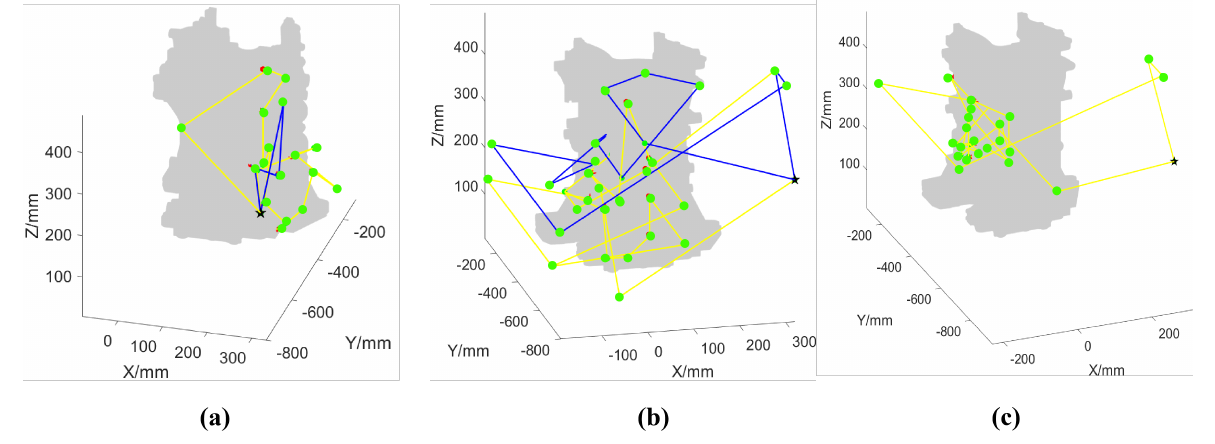
Figure 14. Inspection path diagram based on MSS algorithm. ( a ) Collision-free path for groups 1–2, in which yellow line represents the path of S 1 and blue line represents the path of S 2 . ( b ) Collision- free path for groups 3–4, in which yellow line represents the path of S 3 and blue line represents the path of S 4 . ( c ) Collision-free path for group 5.